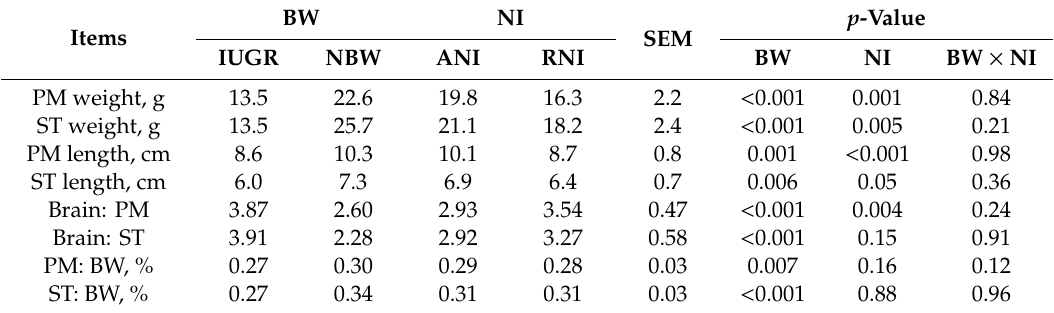
Table 2. E ff ects of the level of nutrient intake on muscle weight of intrauterine growth-retarded (IUGR) and normal-birth weight (NBW) piglets.